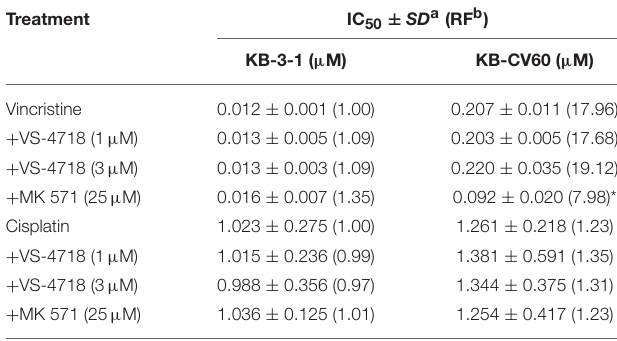
TABLE 4 | VS-4718 sensitized ABCG2-gene-transfected cells to ABCG2 substrates. Treatment